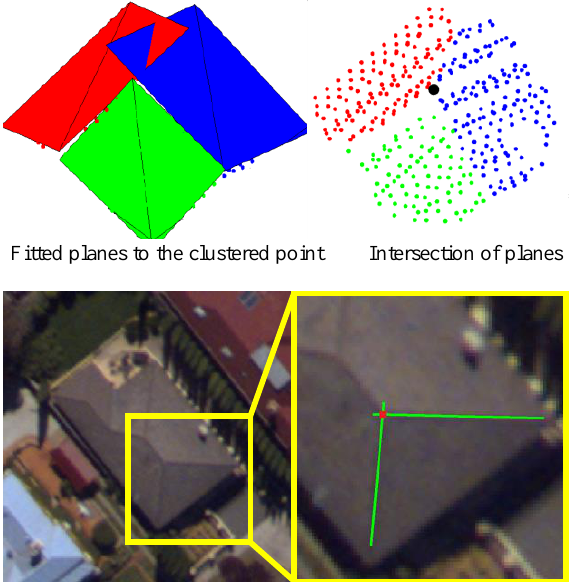
Figure 3. Example corresponding templates: aerial image (left), colour-coded LiDAR DSM (middle) and LiDAR intensity image (right)